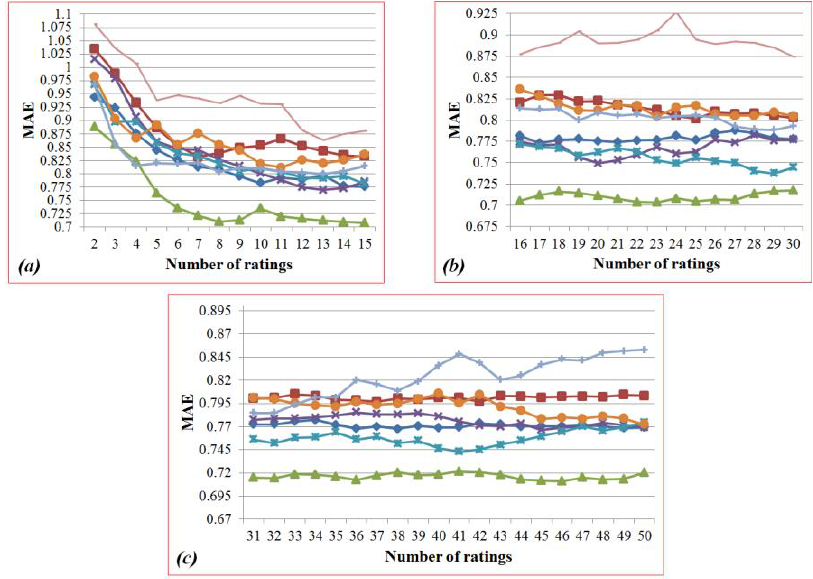
Figure 23. Sub-graphs of Figure 16: ( a ) the ranges from 2 to 15; ( b ) from 16 to 30; ( c ) from 31 to 50.